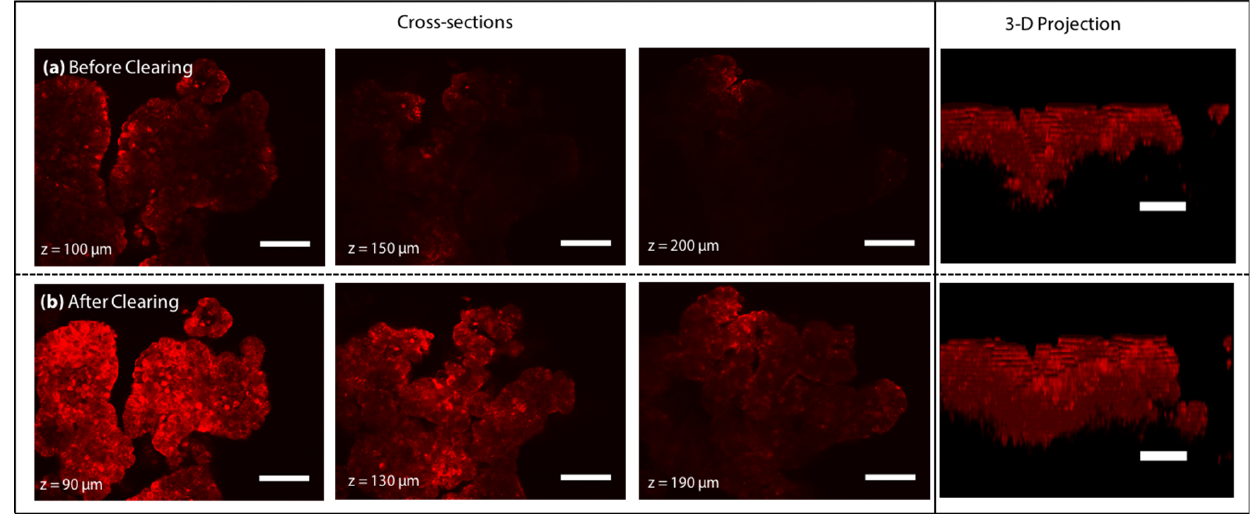
Figure 2. Two-photon microscopy image slices of a tumour spheroid at 100, 150 and 200 µ m deep into the tissue ( a ) before clearing with the corresponding z-stacks and ( b ) after clearing with HyClear-Pre1 solution (changed due to shrinkage). The 3-D projection image of the spheroids is shown on the right. The scale bars represent 100 µ m.